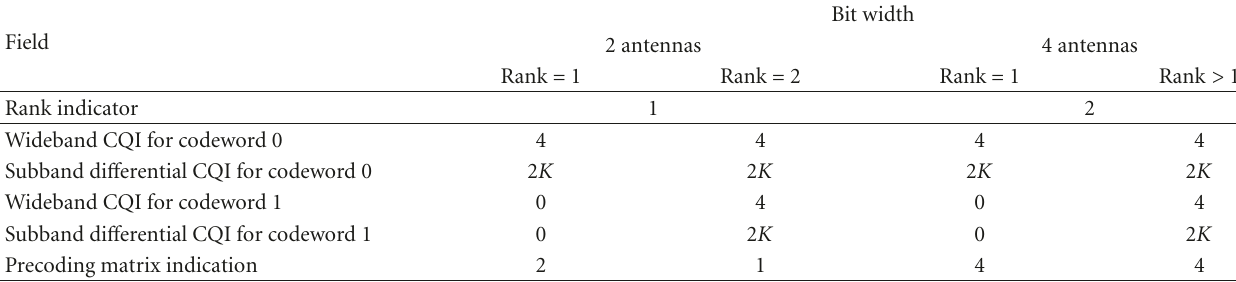
Table 8: Feedback of subband di ff erential CQI and wideband PMI via PUSCH.